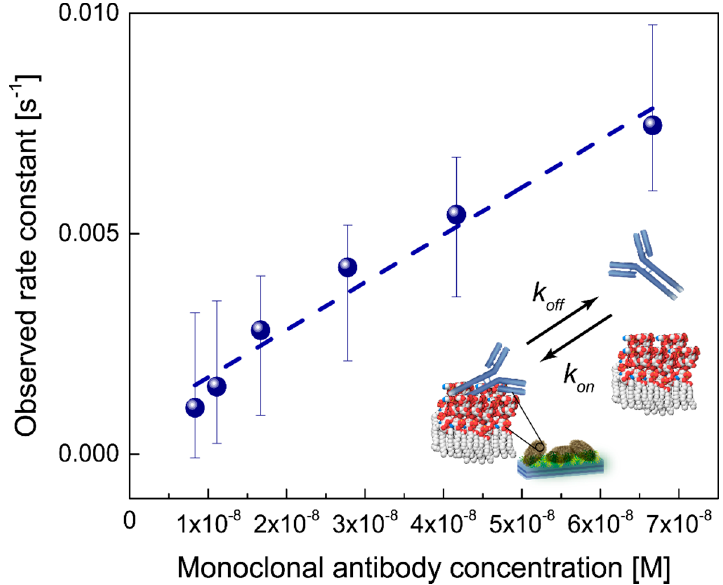
Figure 3. Monoclonal antibody binding. A one-to-one binding model was used to fit the data and obtain the observed rate constant k obs as a parameter (see explanations in the text). This rate constant was subsequently plotted as a function of the antibody concentration and fitted to the straight line for monoclonal antibodies. From the data fit, the dissociation constant for monoclonal antibodies bound to living E. coli DH5 α was equal to 6.2 ± 3.4 nM. The confidence limits for the predicted linear fit were calculated using a classical formula for the confidence interval, which has 95% chance to contain the true parameter value.